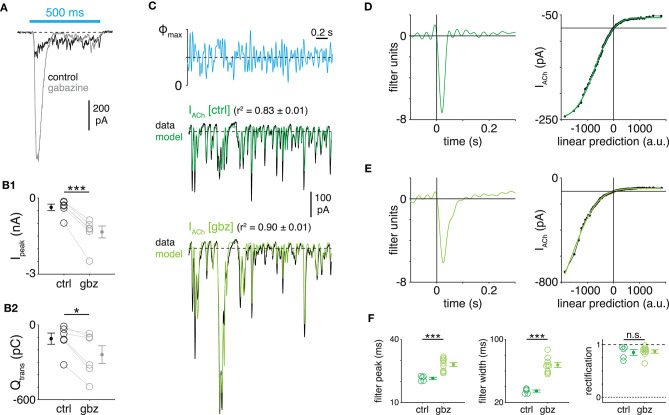
GABAA receptors accelerate cholinergic SAC→DSGC transmission. (A) ChR2-evoked cholinergic EPSCs in an ON-OFF DSGC before (control, black) and during (gray) bath application of gabazine (25 μM). (B) Peak amplitude (Ipeak) (B1) band charge transfer (Qtrans) (B2) of ChR2-evoked EPSCs recorded in ON-OFF DSGCs before (ctrl) and during gabazine application (gbz; n = 6 cells). (C) Linear-nonlinear models of ChR2-evoked cholinergic EPSCs (IACh) recorded in the absence or presence of gabazine. (D) Linear filter (left) and static nonlinearity (right) obtained from a control recording of ChR2-evoked cholinergic EPSCs in an ON-OFF DSGC. (E) Same format as (D) in a different ON-OFF DSGC during application of gabazine. (F) Measurements of LN model components obtained from EPSCs recorded in the absence (ctrl; n = 5 cells) or presence (gbz; n = 9 cells) of gabazine. *p < 0.05; ***p < 0.001.